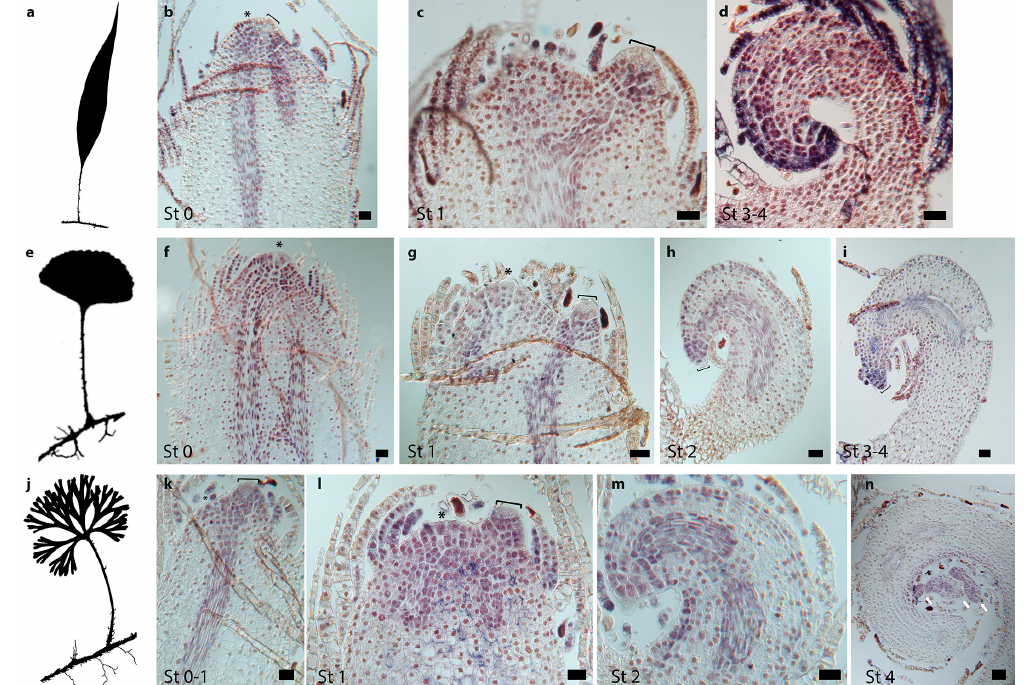
Figure 5. Expression patterns of Class I KNOX genes during leaf development in species of the fern genus Elaphoglossum with simple and divided leaves, longitudinal sections through the shoot apical meristem (SAM) and / or leaf primordia. ( a–d ) Elaphoglossum lloense (simple leaves). ( b–d ) Expression patterns of EllC1KNOX2 . ( b ) Expression throughout the entire apical dome of the SAM and procambium, expression lacking from the incipient leaf primordium. ( c ) Expression throughout the entire young leaf primordium, lacking from the LAI. ( d ) Expression in the apical region, procambium, and the margins distally particularly abaxially. ( e–i ) Elaphoglossum peltatum f. standleyi (simple leaves). ( f–i ). Expression patterns in E. peltatum f. standleyi of ( f–h ) EpsC1KNOX2 and ( i ) EpsC1KNOX1 . ( f ) Expression